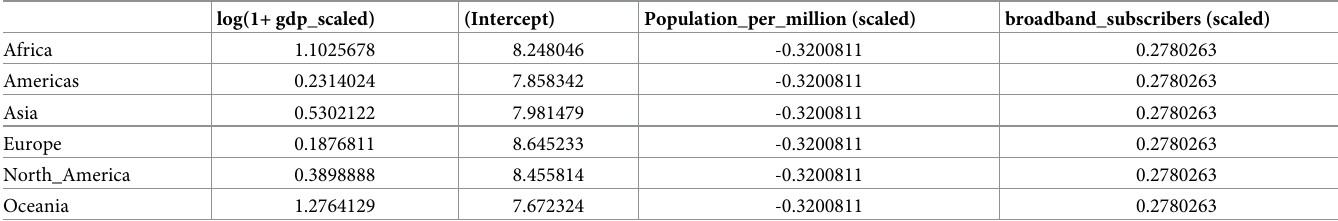
Table 4. Global models III. Random effects model by continent (DV: download per capita). log(1+